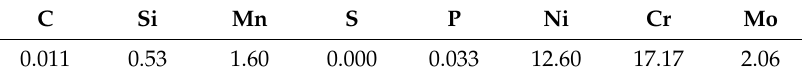
Table 1. Nominal chemical composition of specimen used (mass %).